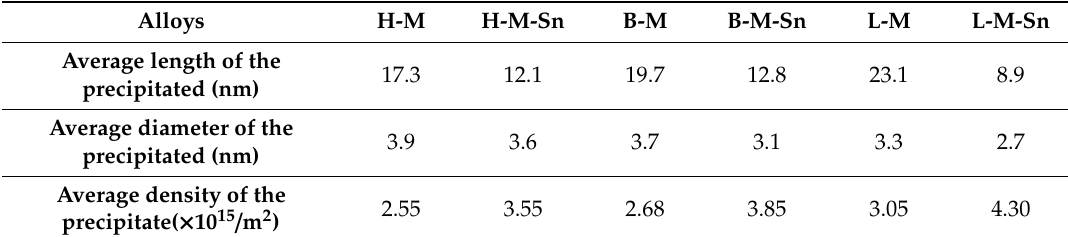
Table 3. Average length, diameter and density of the β ” precipitates at the peak aged.